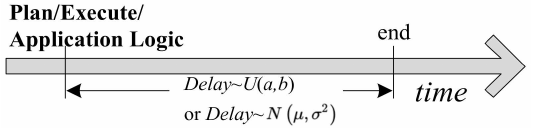
Figure 6. The uncertainty time behavior of Delay.